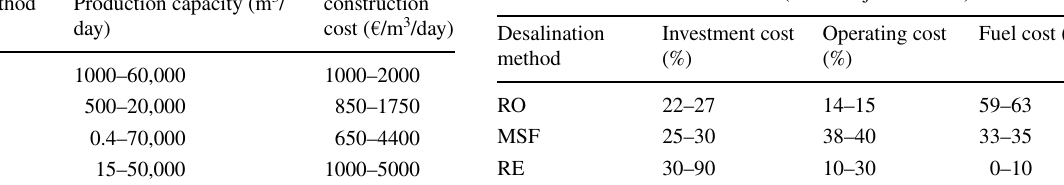
Table 7 Contribution of investment, operating and energy costs in different methods of desalination (Al-Hallaj et al.